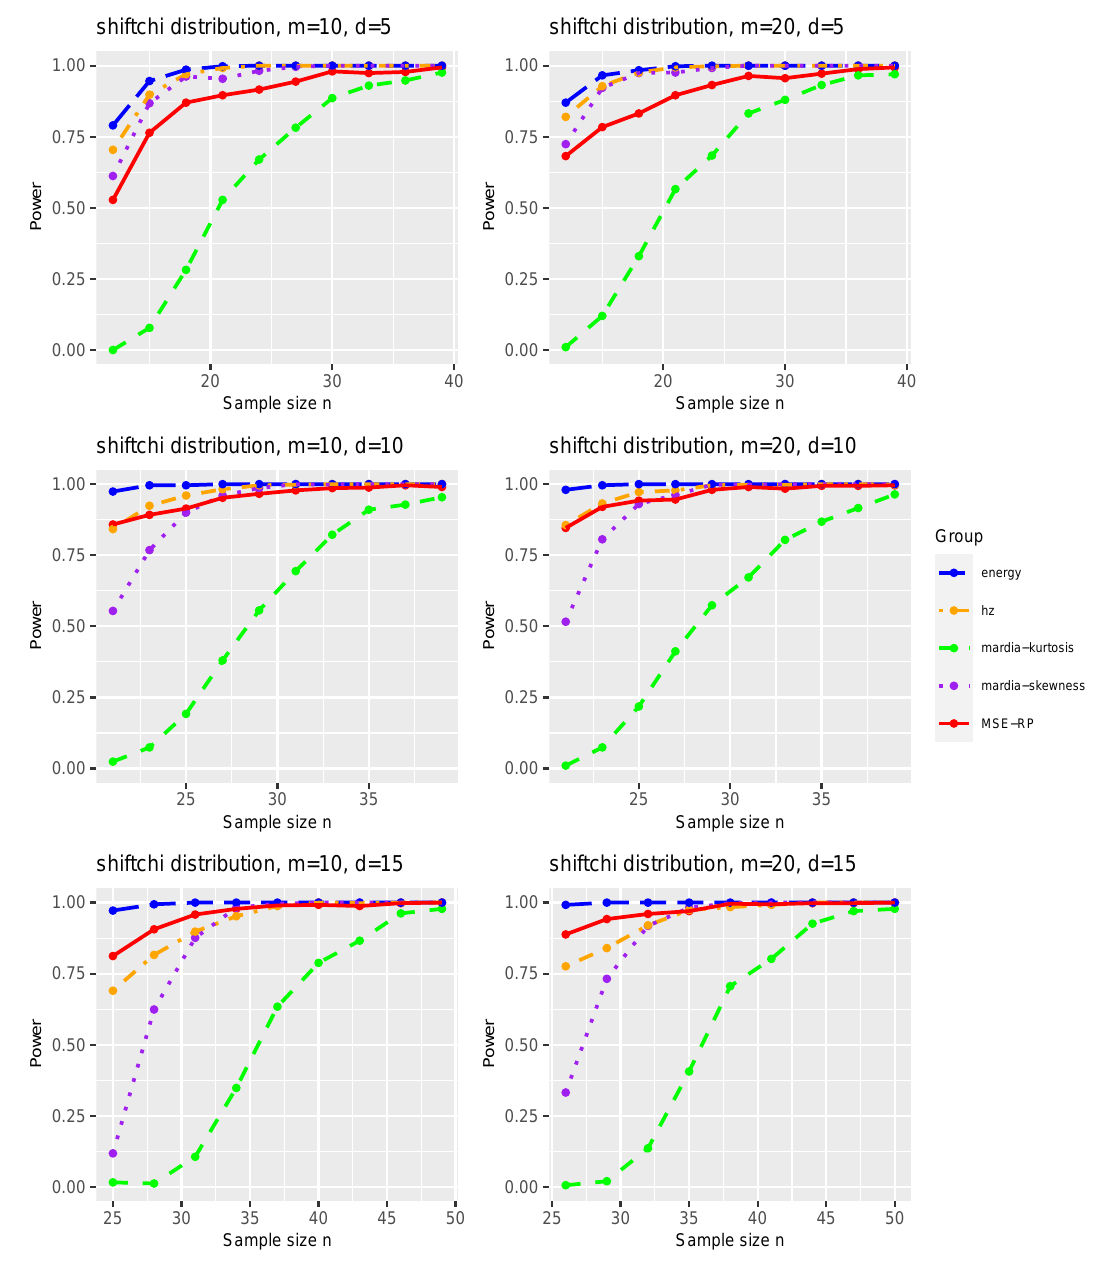
Figure A2. Power ( α = 0.05) comparison for shifted i.i.d. χ 2 ( 1 )